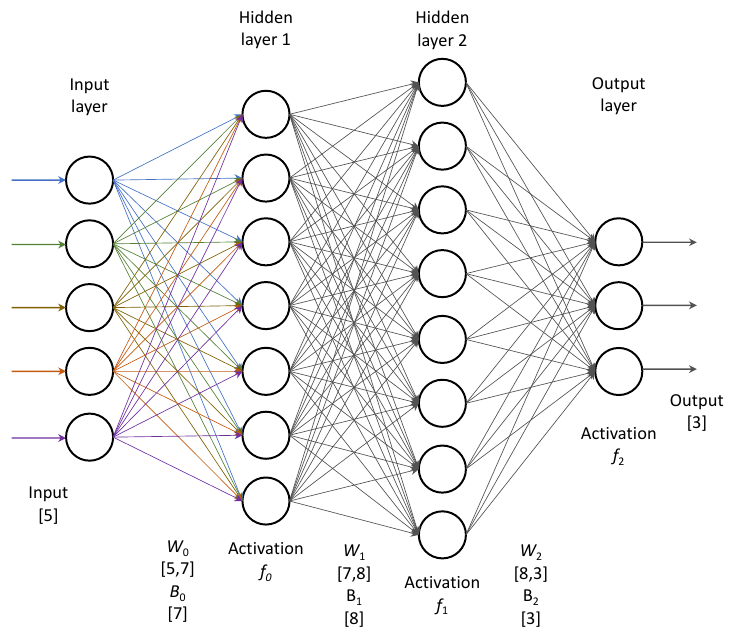
Figure 13. A sample structure of a Multi-Layer Perceptron with five inputs, two hidden layers and three